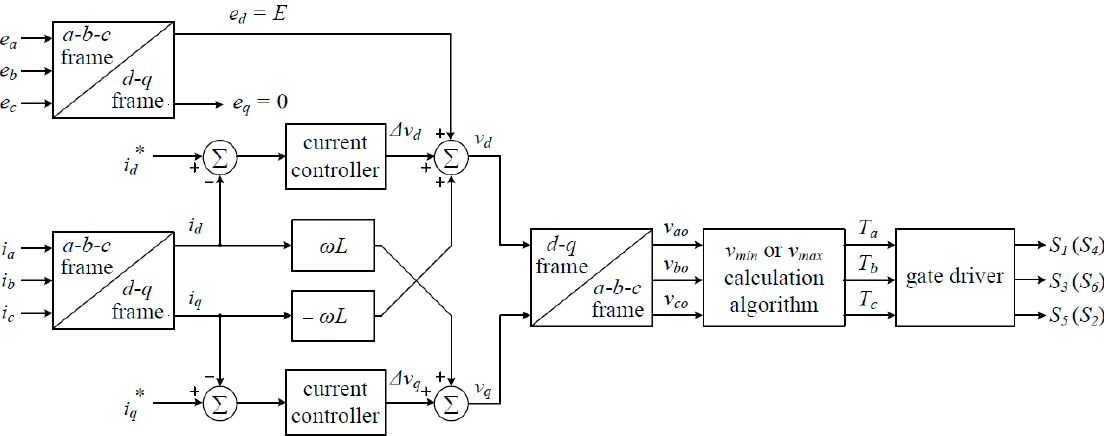
Figure 7. Control block diagram of the proposed inverter.